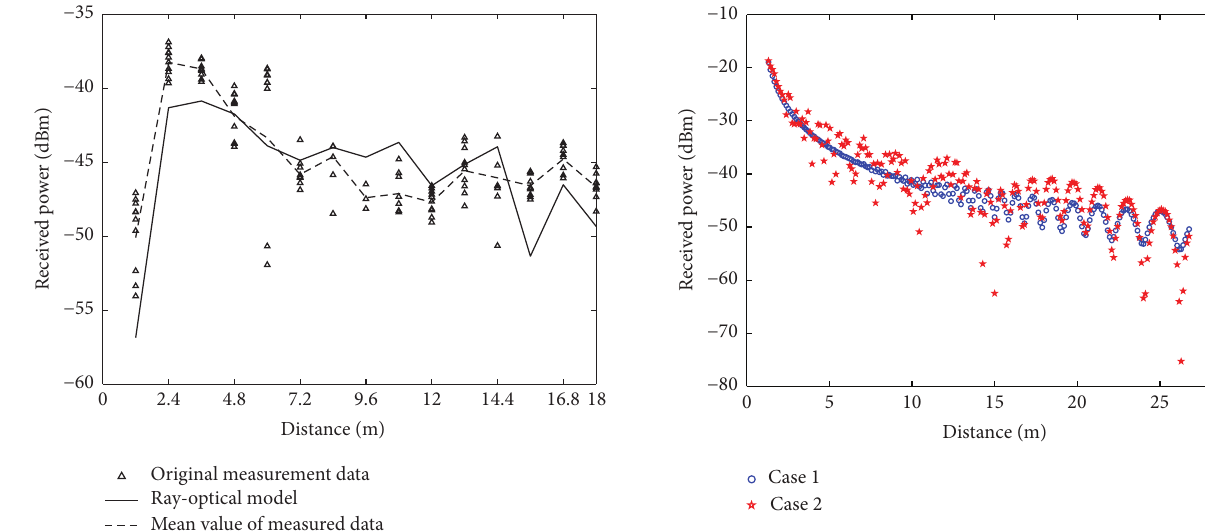
Figure 10: Received power versus link distance derived from ray- optical model and measurements on floor 4.